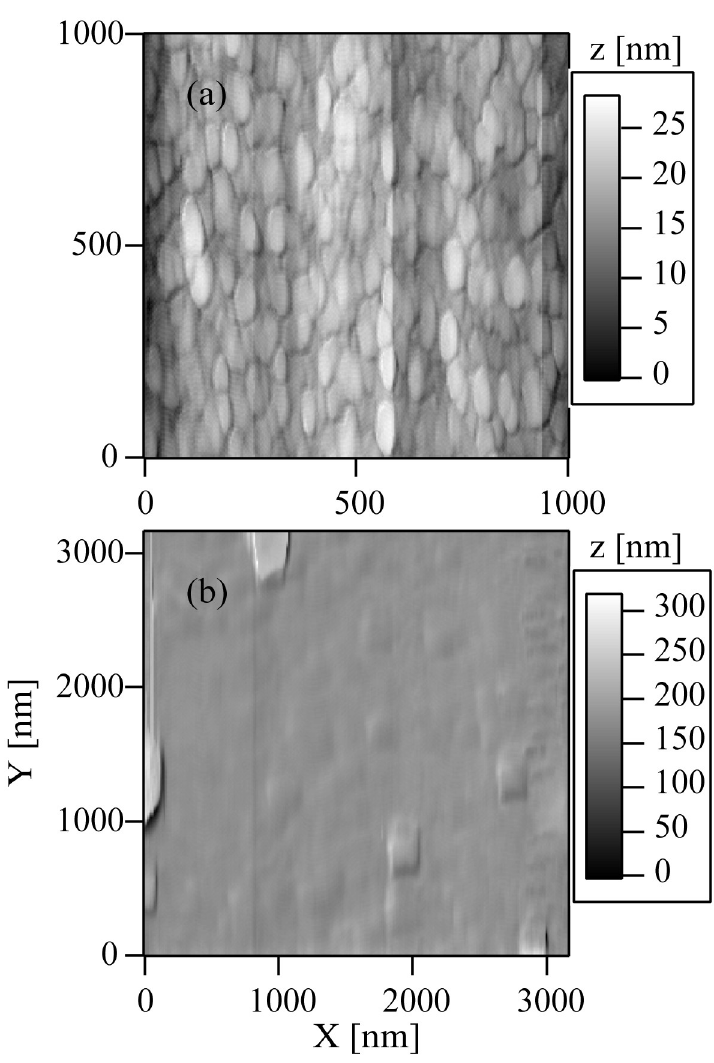
Fig 8. Atomic force microscopy images of films deposited when (a) Ar + and (b) N + ions were injected to Si substrates in conjunction with hexamethyldisilazane. Substrate temperature during the deposition experiments was 540 ˚C. The scale bars located in the right-hand side of the figures (a) and (b) indicate the height in units of nm.